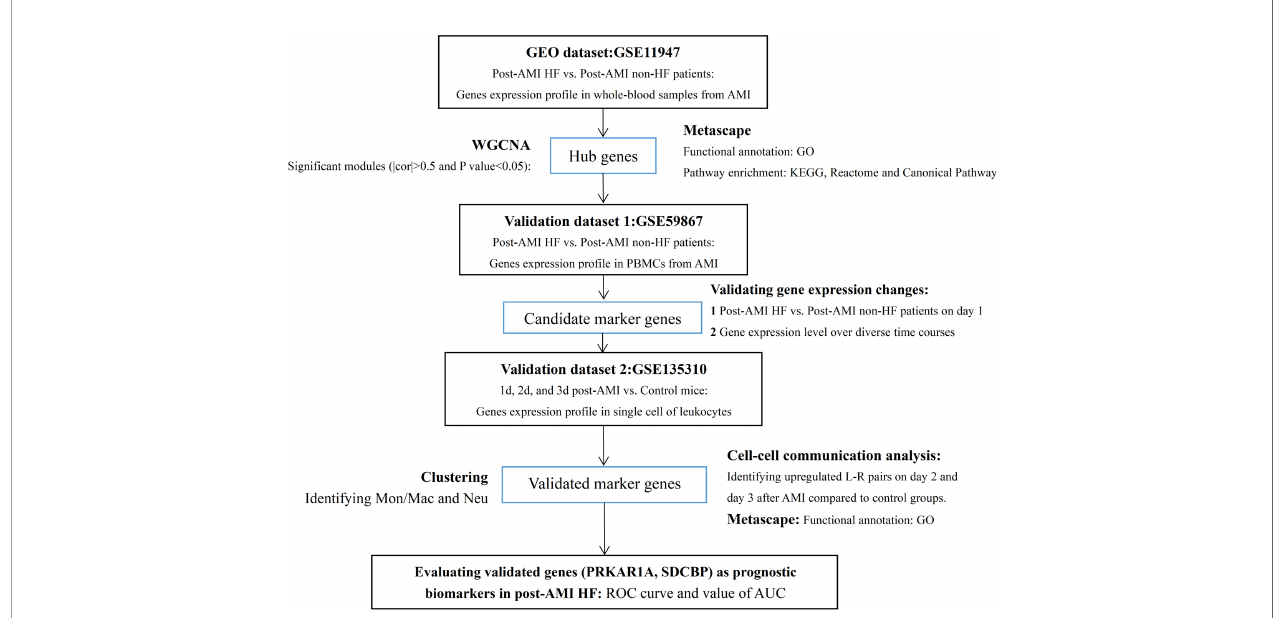
FIGURE 1 | Study fl owchart. GEO, Gene Expression Omnibus; AMI, acute myocardial infarction; HF, heart failure; PBMCs, peripheral blood mononuclear cells; WGCNA, weighted gene co-expression network analysis; cor, correlation coef fi cient; GO, Gene Ontology; KEGG, Kyoto Encyclopedia of Genes and Genomes; Mon/ Mac, monocytes/macrophages; Neu, neutrophils; L – R pairs, ligand – receptor pairs; ROC, receiver operating characteristic; AUC, area under the ROC